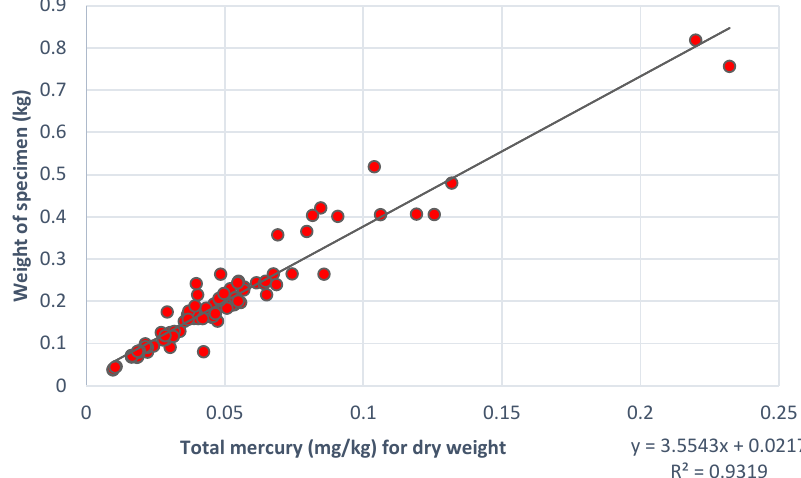
Figure 3. Scatterplot showing the association between total mercury concentration (dry weight) and total fish weight for all fish tissue samples, at 24 sampling sites in the Madre de Dios river basin of Southeastern Peru.